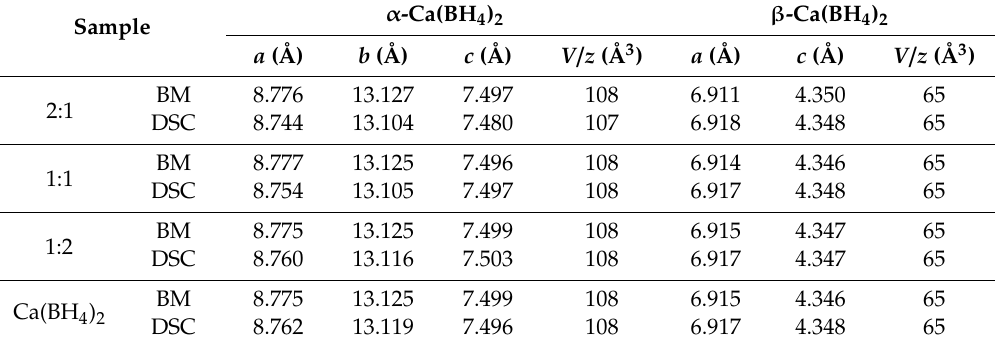
Table 3. Cell parameters ( a , b , c ) and volumes per formula unit ( V / z ) obtained from Rietveld refinement of PXD patterns for α (z = 30) and β (z = 64) Ca(BH 4 ) 2 after BM and DSC cycling under 2 bar of H 2 for pure Ca(BH 4 ) 2 and mixtures (2:1, 1:1, 1:2 molar ratio Mg(BH 4 ) 2 :Ca(BH 4 ) 2 ). After BM and DSC cycling under 2 bar of H 2 , both α the β phases were